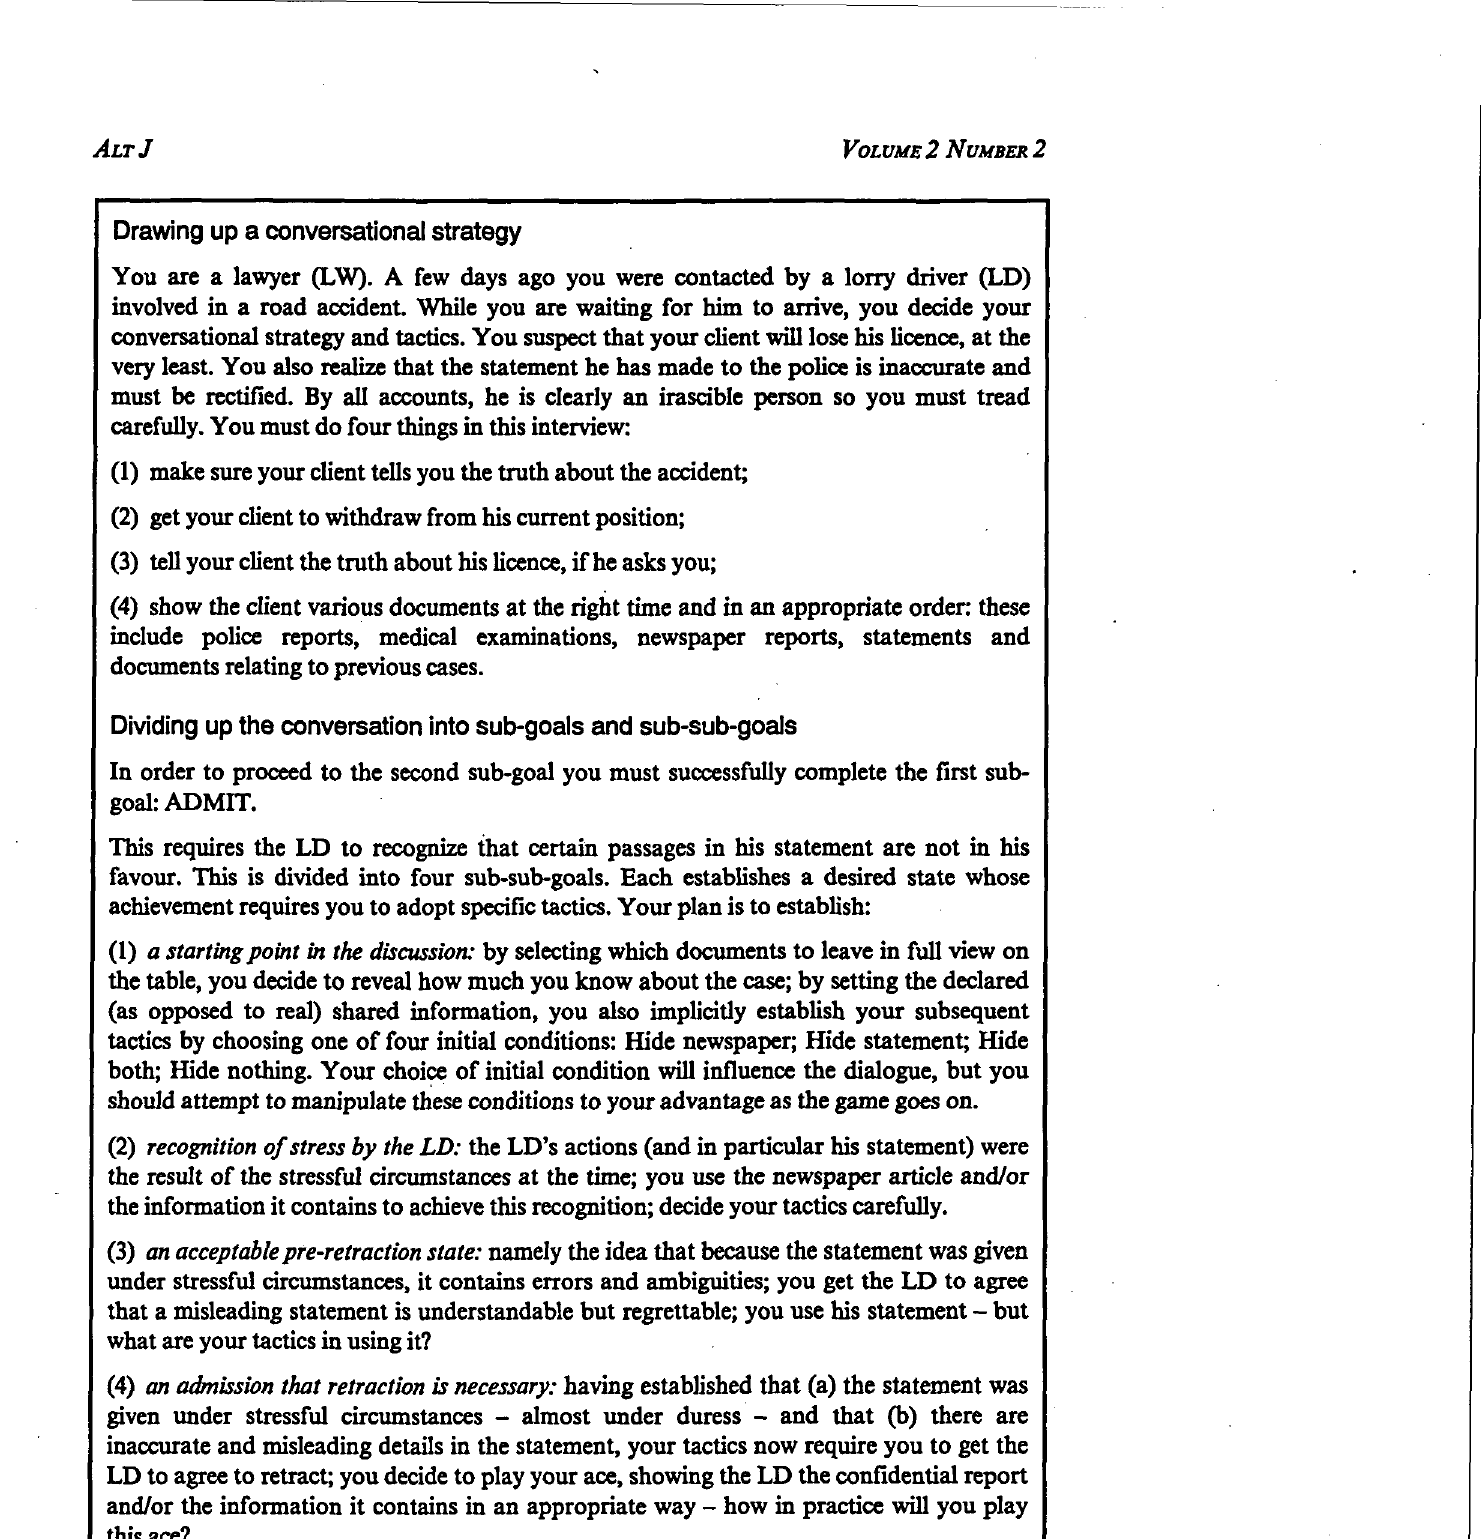
Figure 1: Case notes: the lawyer's conversational